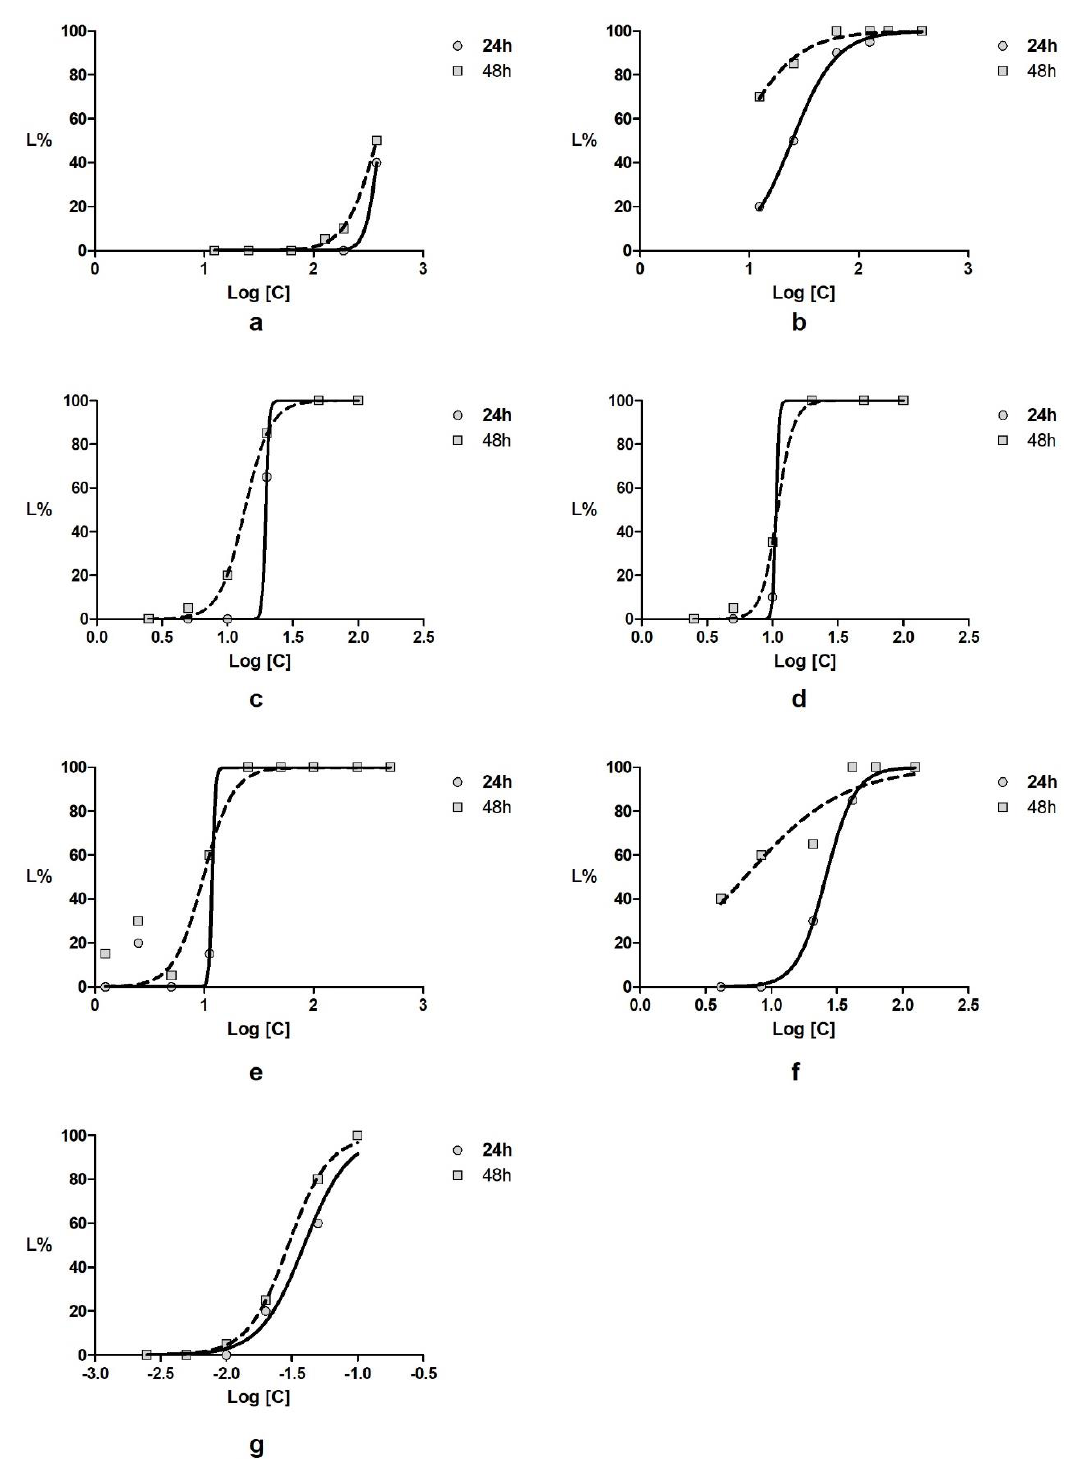
Figure 1. Daphnia magna lethality curves for ( a ) Plantago lanceolata extract; ( b ) Aesculus hippocastanum extract; ( c ) Achillea millefolium volatile oil; ( d ), Taxodium distichum volatile oil; ( e ) mixture of the four active components in ratio of 1.5:0.5:1:1 (g:g:mL:mL); ( f ) diclofenac and ( g ) α-pinene.